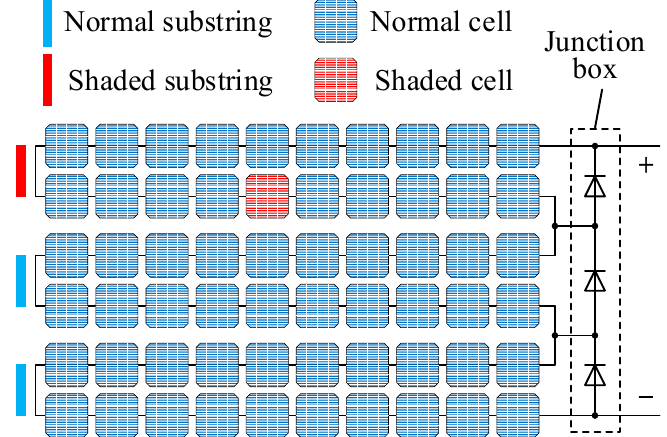
U of the shaded r